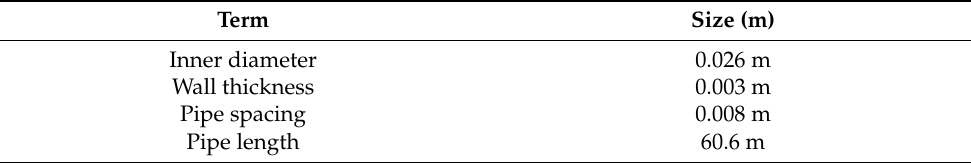
Table 1. Parameters of the HET.